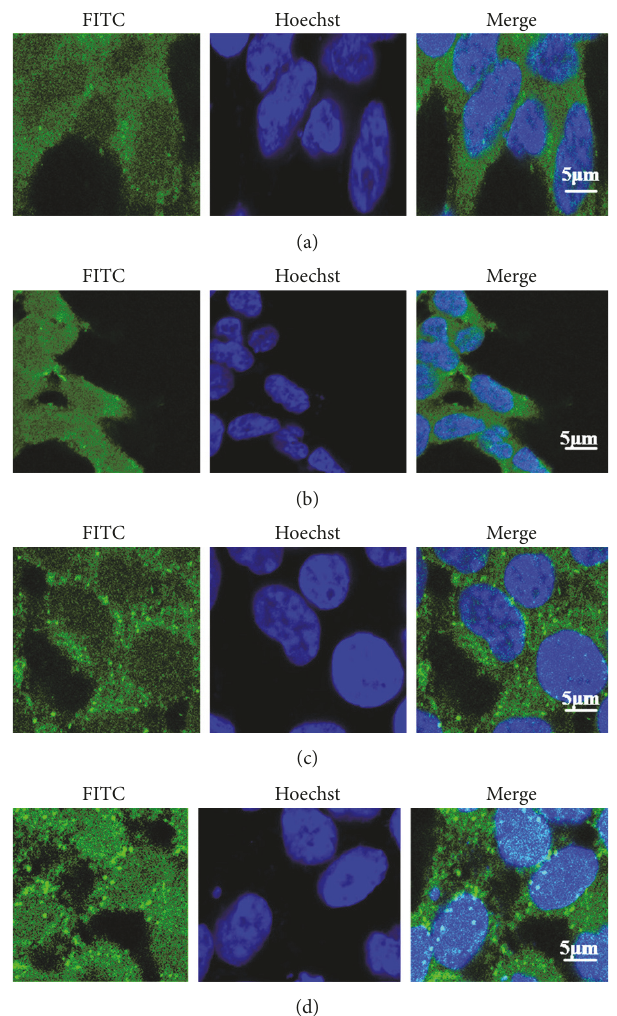
Figure2:AlteredlocalizationofPPAR 𝛾 inresponsetorosiglitazone. (a, c) Control in HEK293 and mIMCD-3 cells, respectively. PPAR 𝛾 immunoreactivity following 24 h of culture without rosiglitazone; (b, d) PPAR 𝛾 immunoreactivity following 24 h of culture with rosiglitazone (10 𝜇 M). Column 2 demonstrates nuclear staining (Hoechst; blue); column 3 illustrates PPAR 𝛾 immunoreactivity (localized using Alexa 488; green). Column 1 features overlay images.PPAR 𝛾 isredistributedtothenucleusinresponsetoelevated rosiglitazone at 10 𝜇